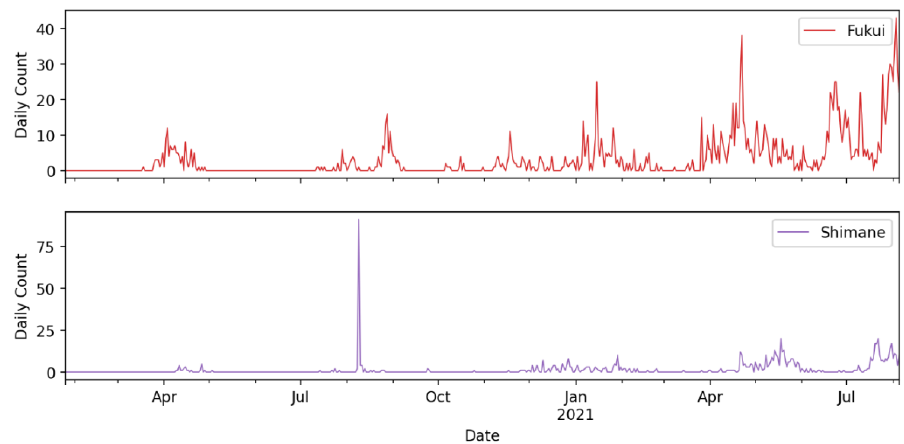
Figure 5. Top five prefectures with the highest K-median values.